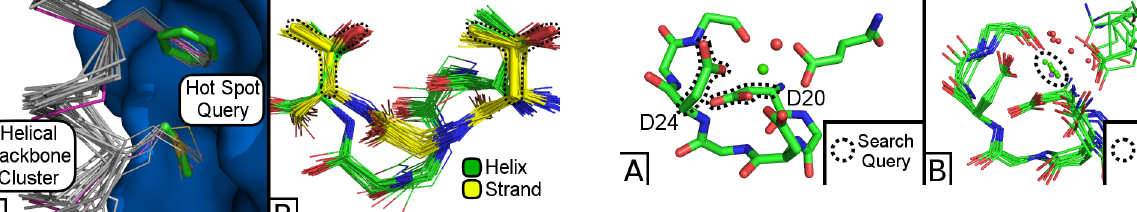
Figure 6. Searching for calcium binding sites. (A) Two side chains of the EF-hand of calmodulin suffice to find matching motifs. The search query (black dashes) consists exclusively of two aspartate side chains (D20 and D24) and does not include the calcium ligand. (B) Searching for these two side chains at 0.7 A˚ resolution returns seven results, all of which are EF-hand motifs. Six of these motifs coordinate a matching calcium ion (green sphere), and the seventh motif coordinates a sodium ion (purple sphere).